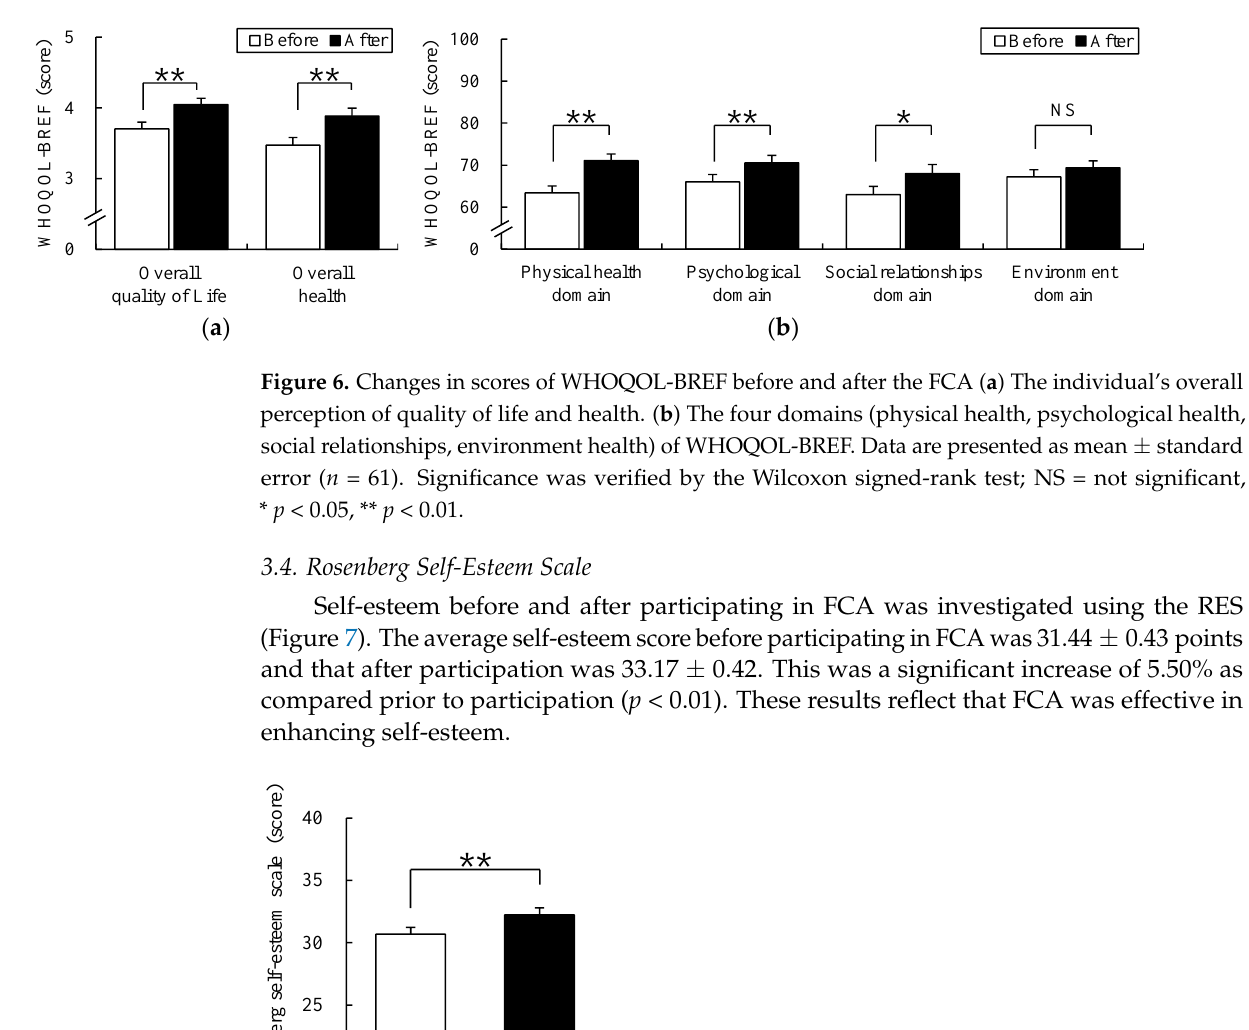
Figure 8. Changes in scores of positive affect and negative affect schedule (PANAS) before and after the FCA. ( a ) Positive affect of PANAS; ( b ) Negative affect of PANAS. Data are presented as mean ± standard error ( n = 61). Significance was verified by the Wilcoxon signed-rank test; ** p < 0.01. 3.6. Perceived Restorativeness Scale The perception of the recovery environment before and after participating in FCA was investigated using the PRS (Figure 9). The resulting average score of the perception of the recovery environment before participating in FCA was 89.91 ± 1.47 points, and the average score of the perception of the recovery environment after participating in FCA was 98.49 ± 1.68. This was a significant increase of 10.74% as compared prior to participa- tion ( p < 0.01). These results suggest that FCAs were effective in improving the perception of the recovery environment.